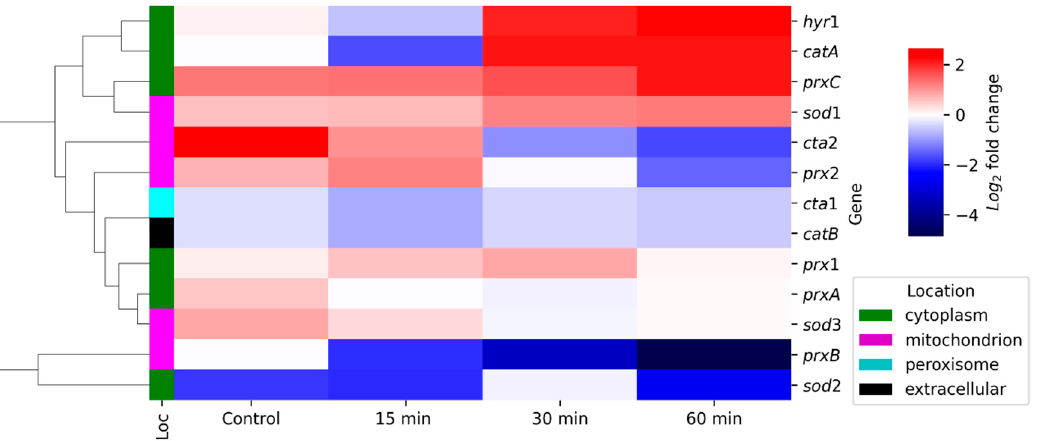
Figure 4. clr3 deletion affects mRNA accumulation of genes encoding ROS detoxifying enzymes including catalases, superoxide dismutases and peroxiredoxins. Expression of oxidative stress genes were investigated by RT-qPCR in the strains subjected to oxidative stress induced by H 2 O 2 (5 mM) during the indicated time points (minutes) at 30 °C. Hierarchical clustering data represent the log 2-fold changes in gene expression in the ∆ clr3 mutant compared to the wild-type strain. Values represent the average value of three independent experiments with two technical repetitions each (see Figure S2). In silico prediction of subcellular location for each enzyme is also shown on the left of the heat map.